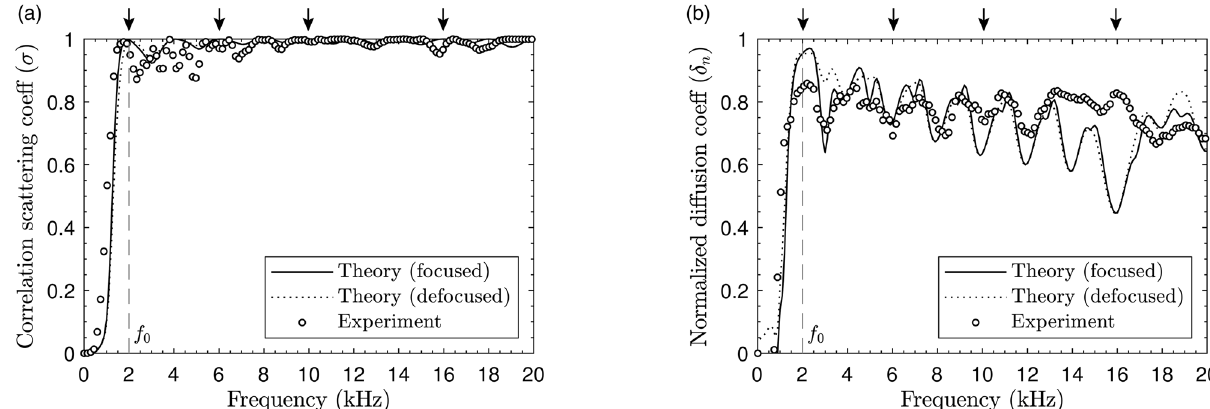
Figure 5. ( a ) Correlation scattering coefficient ( σ ) as a function of the frequency. Arrows indicate the frequencies 2 kHz, 6 kHz, 10 kHz, and 16 kHz. ( b ) Normalized diffusion coefficient ( δ n ) as a function of the Figs. 4(a1-a3), the polar distribution of the scattered waves is uniform when compared to that of the reference reflector, and a reasonable agreement between theoretical and experimental responses is observed. However, all 0 ) in the far field because a vortex is gener- scattered waves interfere destructively in the specular direction ( θ = ated in the near field. Therefore, metasurfaces based on holographic vortices inhibit specular reflections because the field presents a phase dislocation in these directions. In addition, the scattering function for all other angles is uniform in the far field, since the waves diverge spherically from the focal point. 3 ), 10 kHz ( l 5 ) and 16 kHz ( l 8 ) is depicted in The scattered field at frequencies 6 kHz ( l = = = Fig. 4b1–b3,c1–c3,d1–d3, respectively. The amplitude of the scattered field decreases over a wider range of